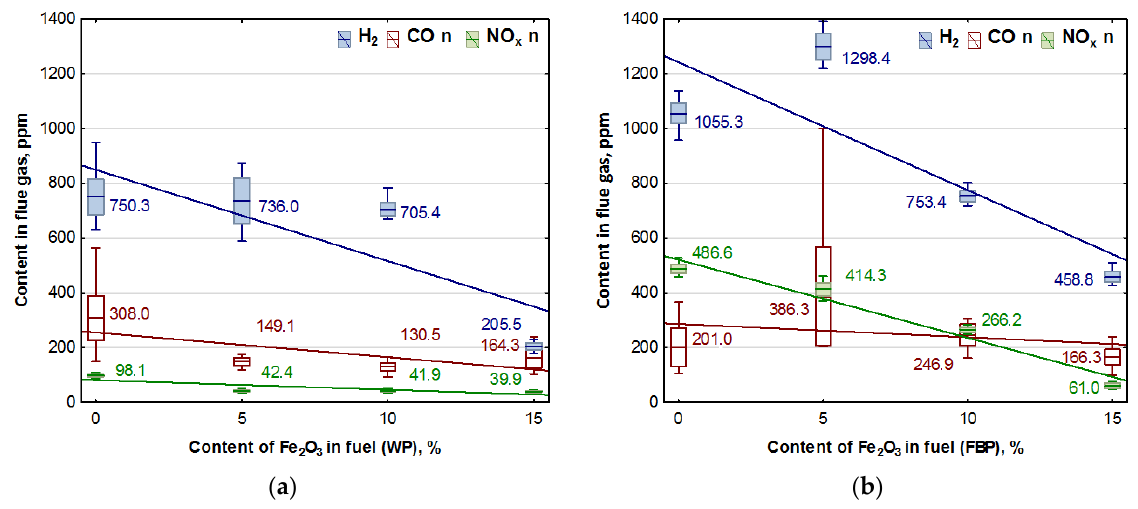
Figure 4. Impact of Fe 2 O 3 content in fuel on hydrogen, carbon monoxide, and NO x contents in flue gases from the combustion of: ( a ) Wood pellets (WP); and ( b ) Furniture board pellets (FBP). Table 5. Equations describing trend lines and the values of p -coefficient.